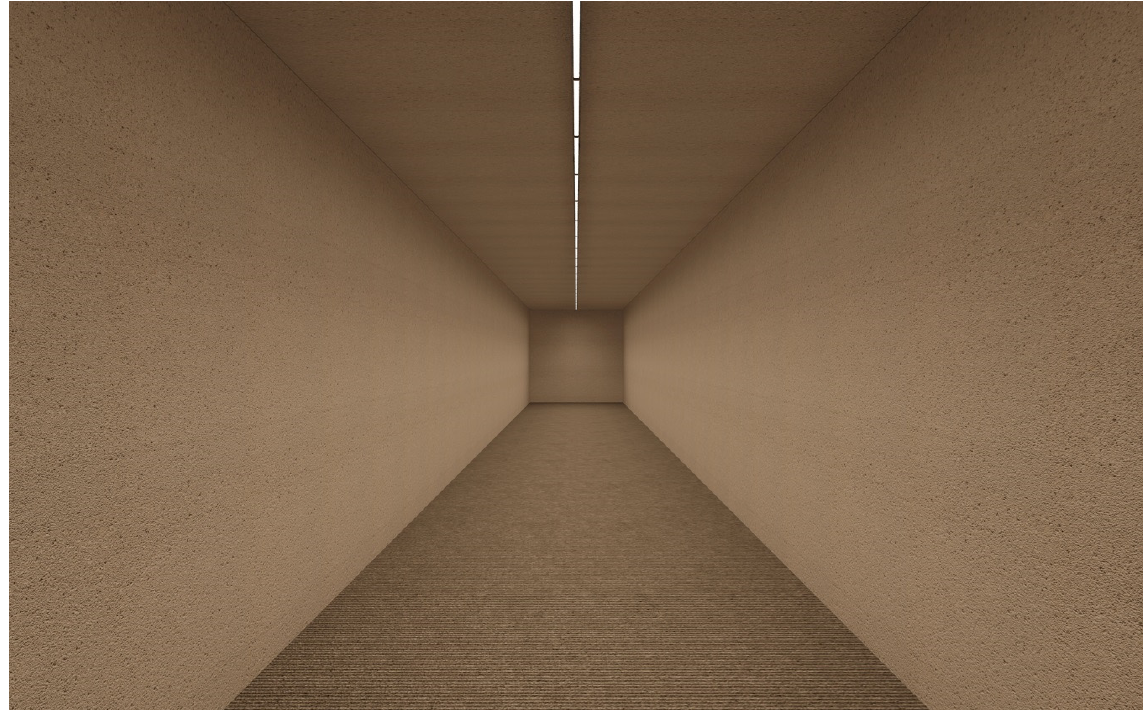
Figure 6. Computer simulation of corridor lighting for variant 3.